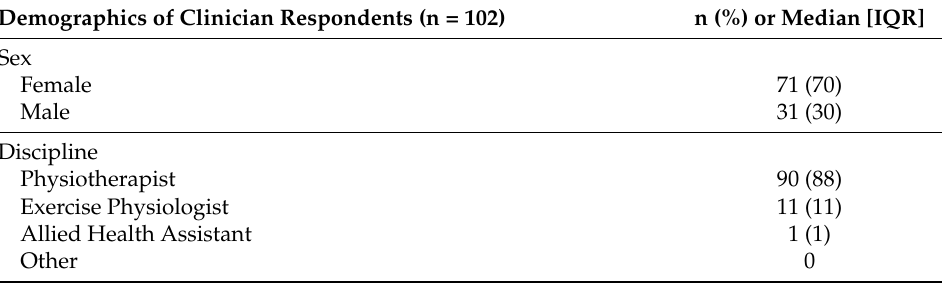
Table 1. Characteristics of responding clinicians and health